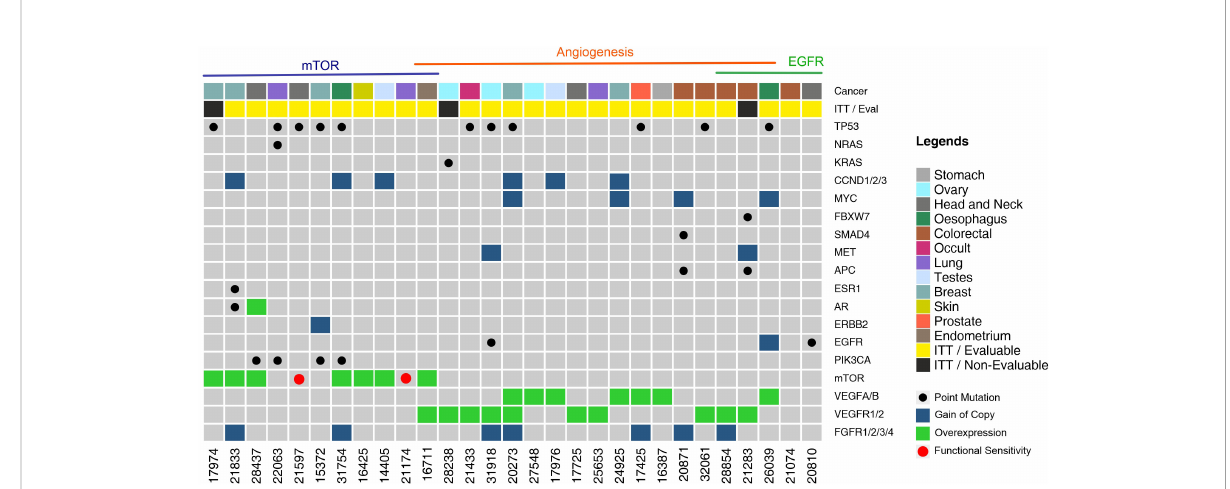
FIGURE 3 Landscape of Genomic Alterations in the Prospective Intent to Treat (ITT) Population. Each vertical column indicates a single patient (patient number in the bottom X-axis). Vertically stacked grey boxes in each column indicate individual genes (gene names on right Y-axis). Black dots within each box indicates a point mutation (single nucleotide variation), red dots indicate in vitro sensitivity (chemo response pro fi ling, CRP), blue shaded boxes indicate gain of gene copy (CNV gain), green shaded boxes indicate gene overexpression. Patients are grouped by observed targetable molecular indications. Colour coded boxes in the topmost row indicate cancer